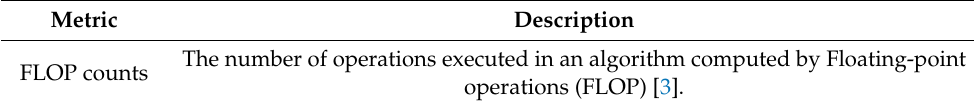
Table 3. Set of metrics that quantifies the computational